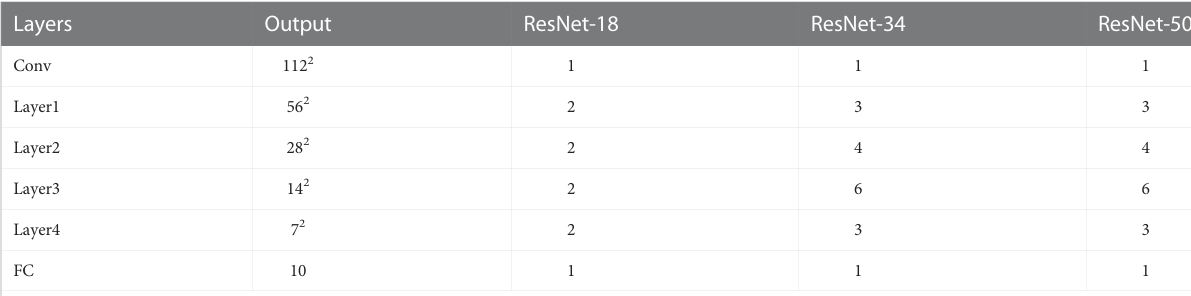
TABLE 2 The amount of residual block repetitions for ResNet models of different depths.